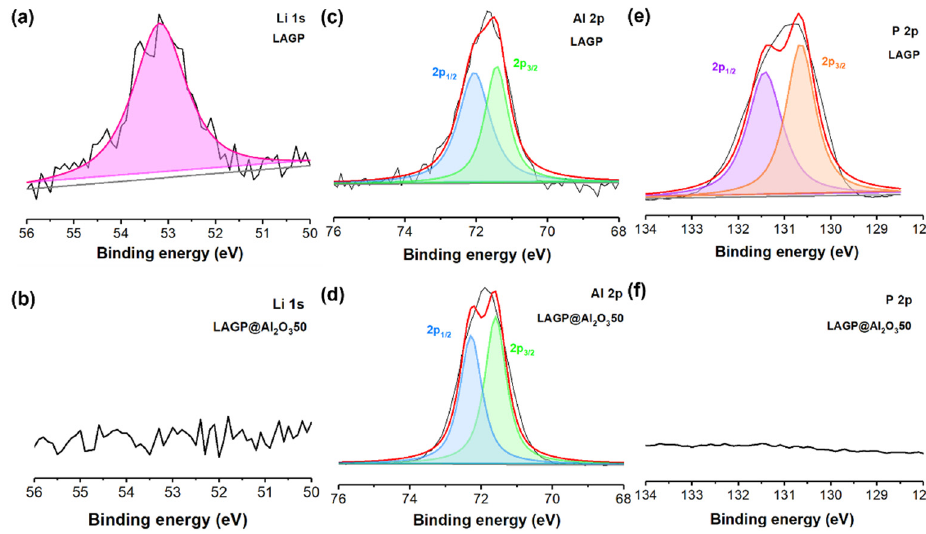
Figure 4. XPS spectra of ( a , b ) Li 1s, ( c , d ) Al 2p, and ( e , f ) P 2p of LAGP and LAGP@Al 2 O 3 50.